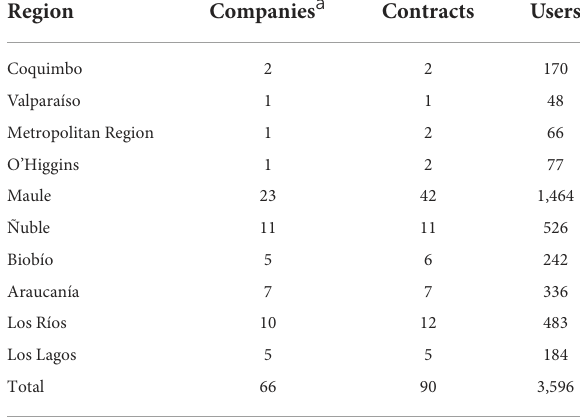
TABLE 1 PAP users by region,